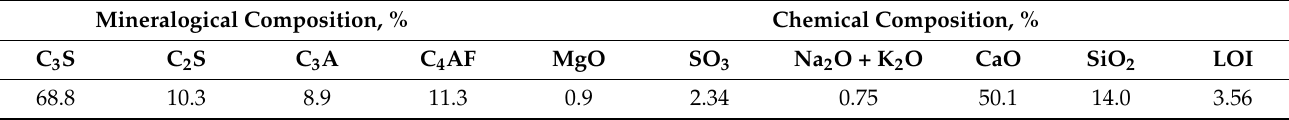
Table 2. Mineralogical and chemical composition of Portland